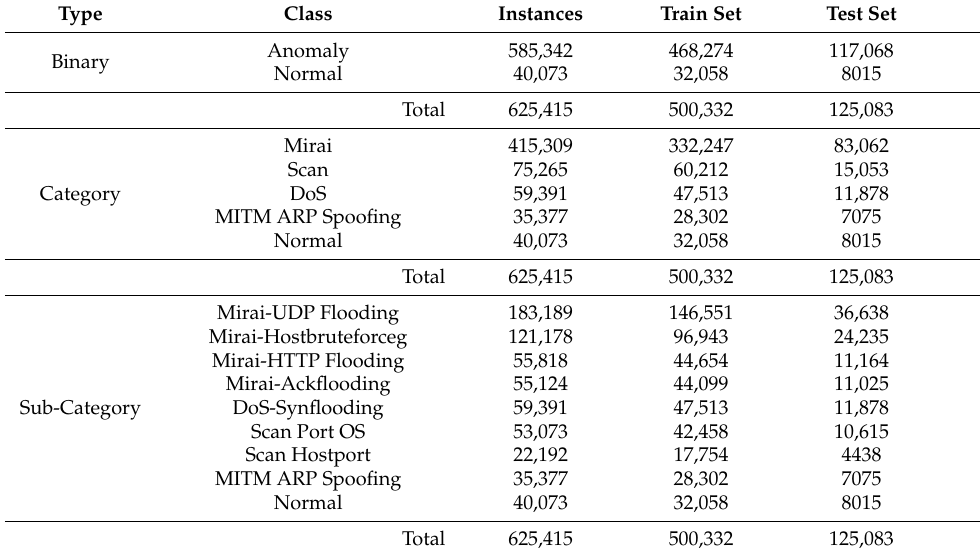
Table 3. A detailed distribution of IoTID20 dataset in train and